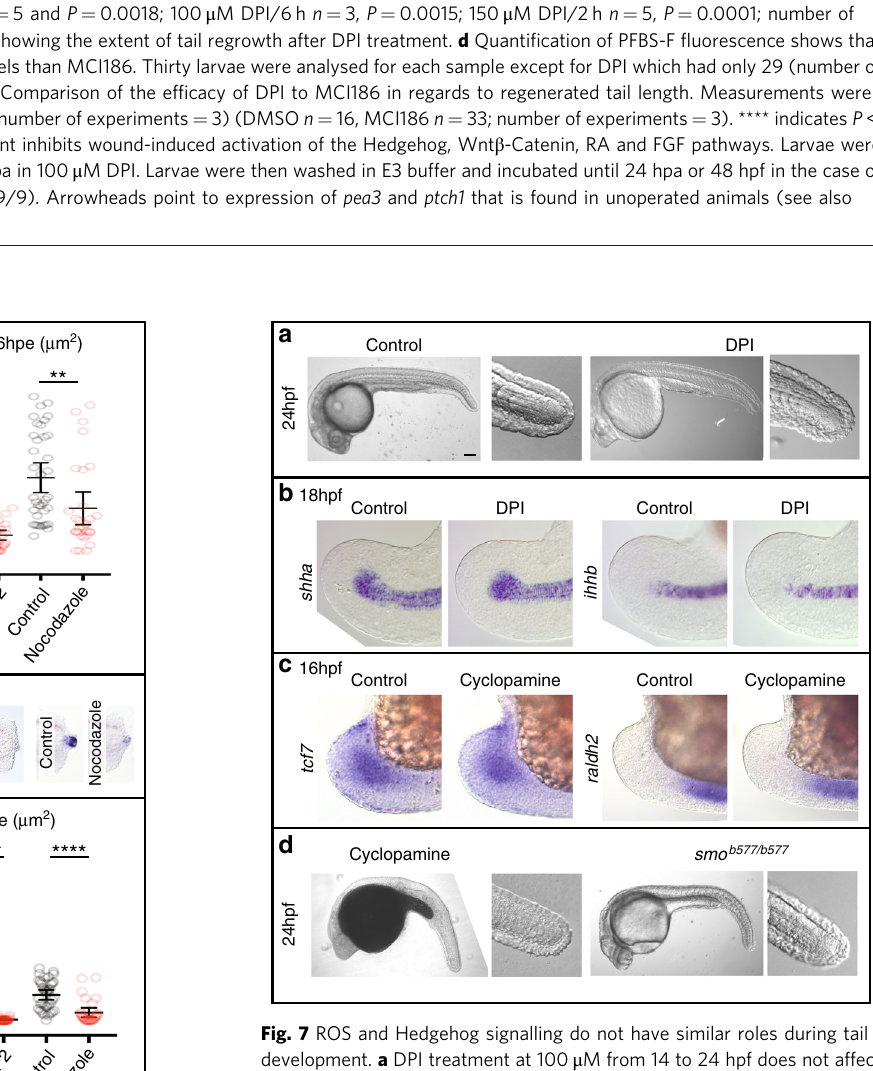
Fig. 5 ROS activity immediately after tail excision. a Time course showing production of ROS after tail excision is reduced in larvae treated with 150 μ M DPI